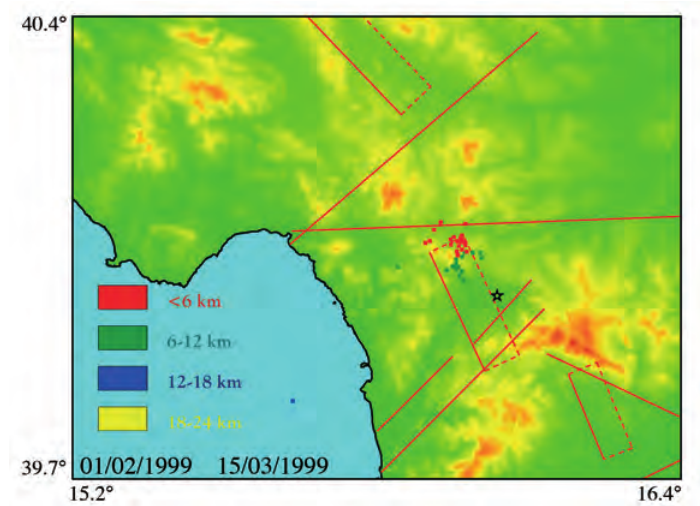
Fig. 12. Event locations in the time interval 01/02/1999-15/03/1999.